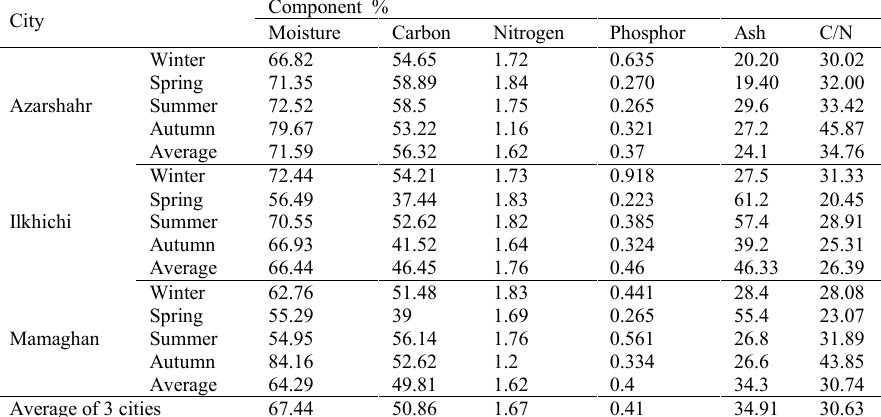
Table 5. Moisture content and chemical characteristics of organic and food wastes at studied cities in different seasons City